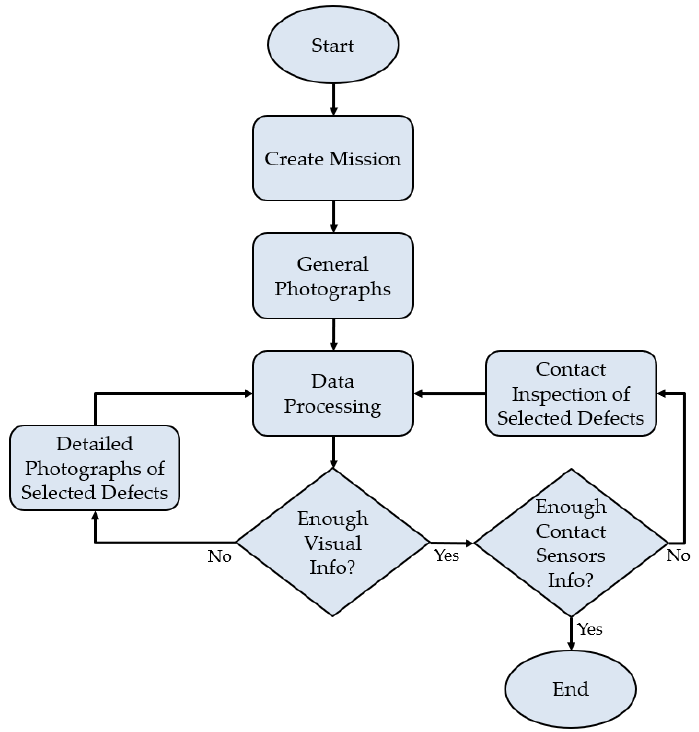
Figure 2. General viaduct inspection